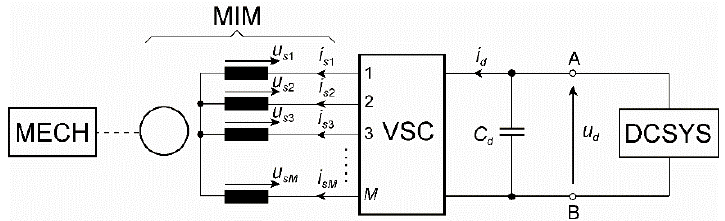
Figure 1. Connection of the M -phase MIM with the VSC and the mechanical system MECH.